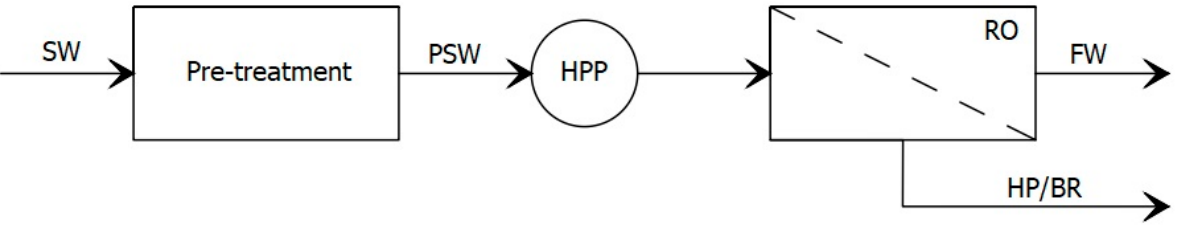
Figure 3. Schematic diagram of a traditional RO seawater desalination process TSWRO. The pre-treatment unit removes particles and suspended solids in the feed stream that may cause fouling and scaling on the RO membrane surface. The high-pressure pump (HPP) raises the feed pressure from atmospheric to a value adequately higher than the osmotic pressure of the final brine. Then, PSW enters the RO system, where FW flows through the semipermeable membranes while the salts are almost entirely rejected. The Permeate FW is taken as a product after minor treatment at atmospheric pressure, while the pressurized retentate or brine, HP/BR, is a waste characterized by high salt concentration (TDS brine >> TDS seawater ). TSWRO initially operated at the lowest possible pressure to avoid membrane modules’ mechanical stress and minimize the energy for feed pressuri- zation. The recovery, operating in this condition, was low, and the TDS of brine was not significantly different from the TDS of PSW. With better performing membranes and new